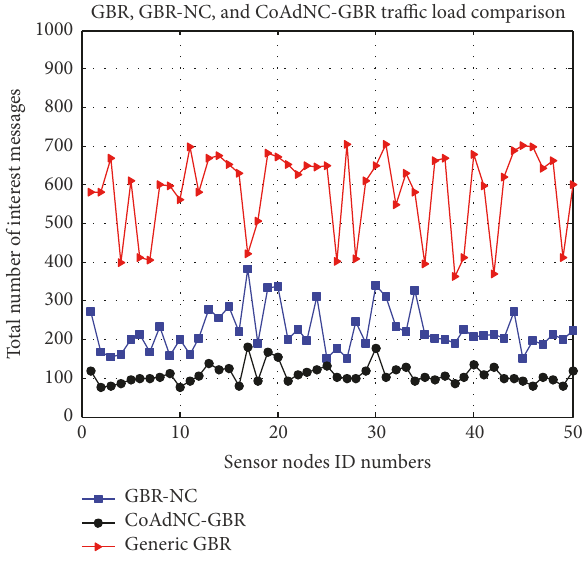
Figure 4: CoAdNC-GBR, GBR-NC, and Generic GBR: traffic load comparison.